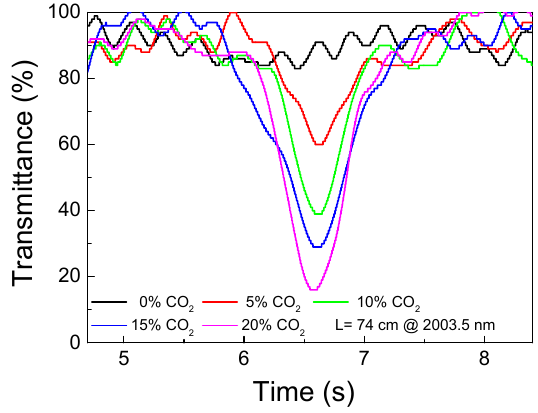
Figure 6. Typical normalized optical signal at different concentration levels.